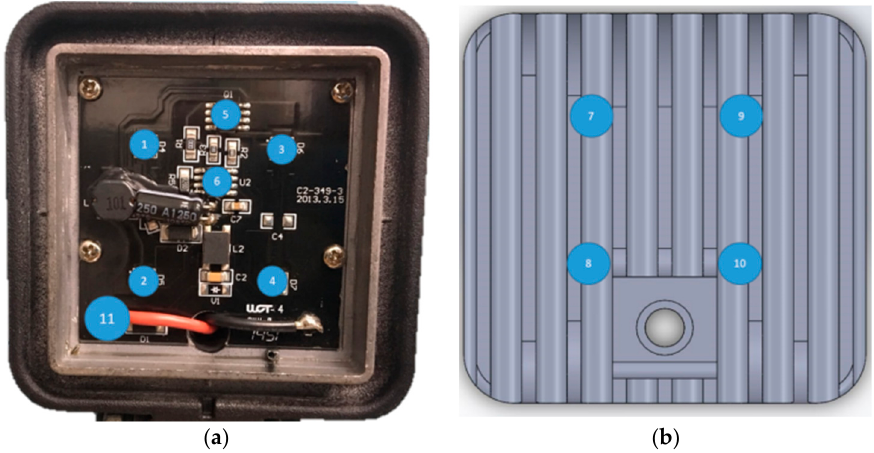
Figure 4. Position of thermoelectric coupling measurement points. ( a ) LED thermocouple measurement points (front). ( b ) LED thermocouple measurement points (back).